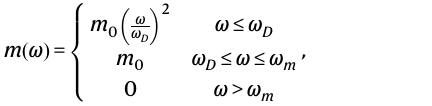
deviation of the MDC fi ts, which isconverted to energy bymultiplying the velocity ofthebareband.TheRe Σ ( ω )ofpristineCsV 3 Sb 5 isplottedascoloredshadowsfora directcomparison.ThesolidblackcurvesarethereproducedRe Σ ( ω )viamaximum entropy method. The dashed blue and gray line represents the slope of the Re Σ ( ω ) at E F in Cs(V 0.93 Nb 0.07 ) 3 Sb 5 and CsV 3 Sb 5 , respectively. e Extracted Eliashberg function α 2 F( ω ). f EPC strength λ estimated from the α 2 F( ω ), which is plotted as a function of T c . The error bar for λ is determined by the standard deviation of the Re Σ ( ω